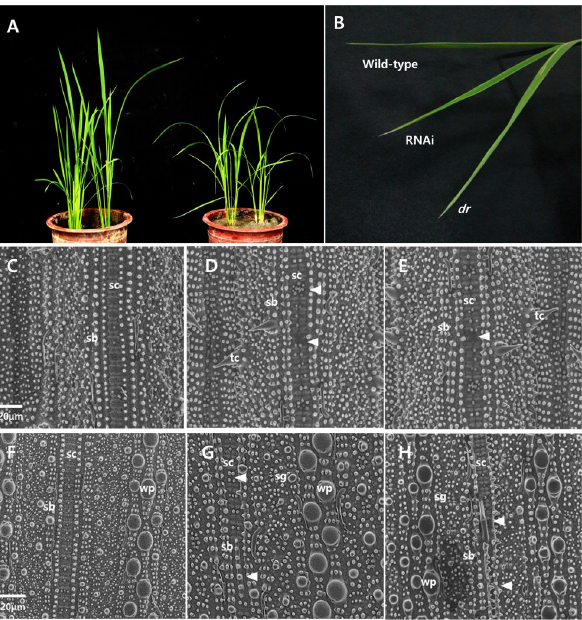
Fig 8. Comparison of the wild-type, dr mutant, and the RNAi plant leaf epidermal phenotypes using SEM (100 × magnification). (A) Overall shape of plants on 60-day-old in the wild-type (left) and the RNAi (right). (B) Comparison leaf shape in the wild-type, RNAi and the dr mutant. (C, D, E) The adaxial surface in the wild-type, RNAi and the dr mutant. (F, G, H) The adaxial surface in the wild-type, RNAi and the dr mutant. sb; silica body, sc; silicified dumbbell- shaped cells, sg; stomatal guard, pr; protuberances, tc; trichome, wp; wart-like protuberance. Arrow heads indicate undeveloped or degraded silica cells. Bars = 20 μ